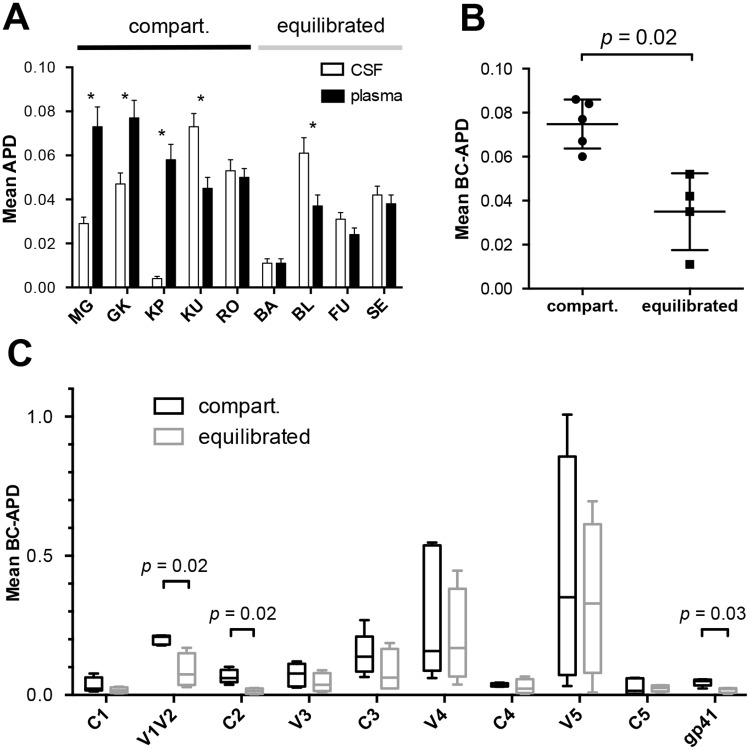
Amino acid diversity of HIV-1 env among contemporaneous CSF and plasma viral populations.(A) Box plot representing, for each patient, amino acid mean average pairwise distance (APD) between SGS sequences in paired CSF (white) and plasma (black) samples. Patients are grouped according to evidence of compartmentalization in CSF (* = significant difference between CSF and plasma population diversity by t-test, p < 0.001). (B) Mean APD between compartments (BC-APD, CSF vs. plasma) is shown for all patients. BC-APD was significantly greater for subject with compartmentalized viral populations (Mann-Whitney test, p = 0.02). (C) BC-APD was calculated across all regions of HIV-1 env for subjects with (black box plot) or without (grey box plot) evidence of CSF compartmentalization. The Wilcoxon matched-pairs ranked test and the Mann-Whitney test were used to determine p-values for paired observations (CSF vs. plasma) and observations between viral population structures (compartmentalized vs. equilibrated), respectively. Non-significant p-values are not represented. Compart.: evidence of CSF viral compartmentalization.